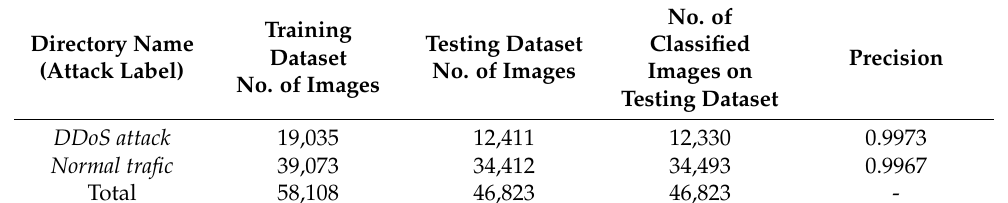
Table 8. Precision of recognized images using ML.NET created model on BOUN DDos training dataset.